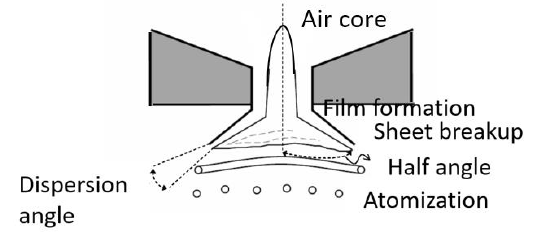
Fig. 7. Schematic process of atomization by LISA model